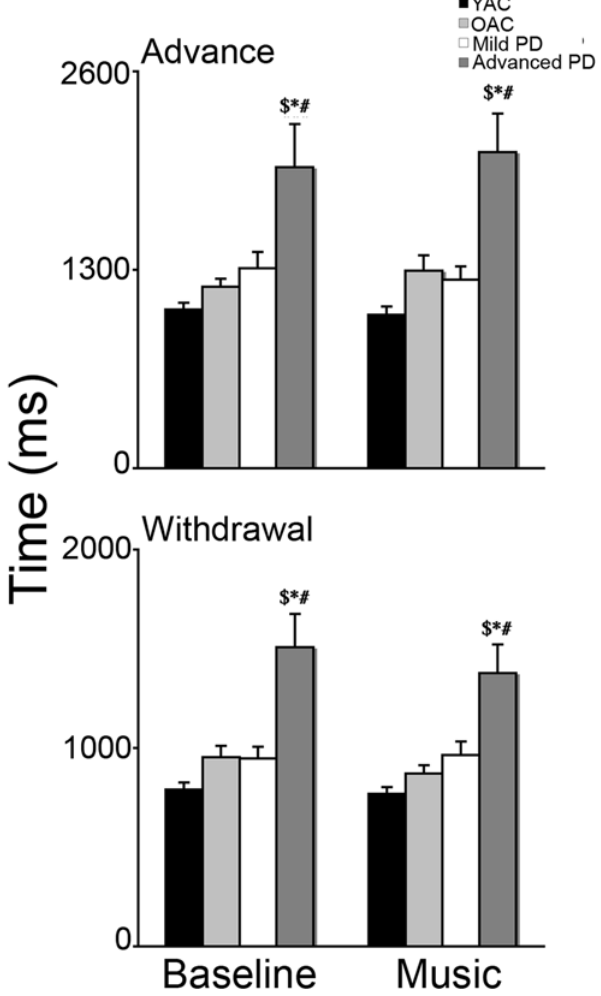
Figure 9. Time to complete advance and withdrawal (mean and standard error) for each group. $ =Advanced PD . YAC; *=Ad- vanced PD . OAC; # =advanced PD . mild PD, p , 0.001.